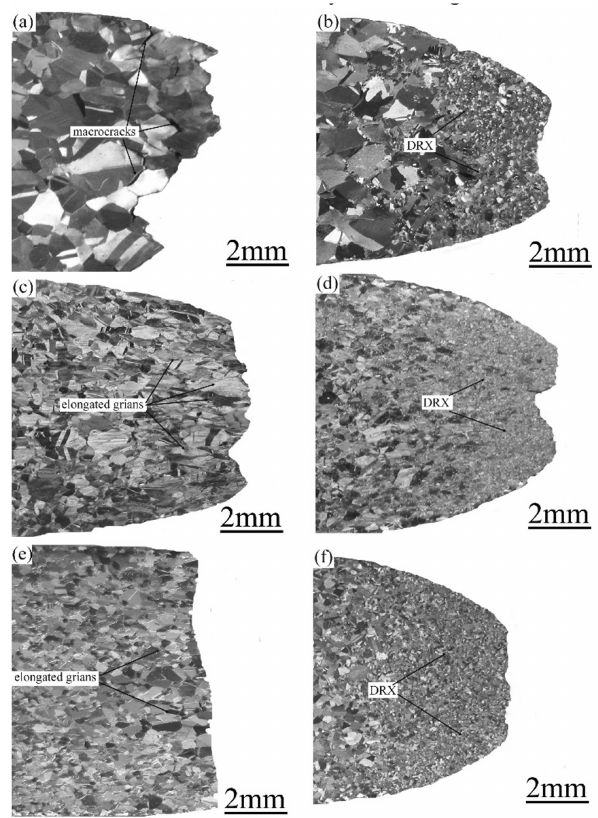
Figure 10: Macrographs of longitudinal sections close to the fracture of alloy 1: (a) alloy 1 at 1050°C, (b) alloy 1 at 1100°C, (c) alloy 2 at 1000°C, (d) alloy 2 at 1050°C, (c) alloy 3 at 950°C, (d) alloy 3 at